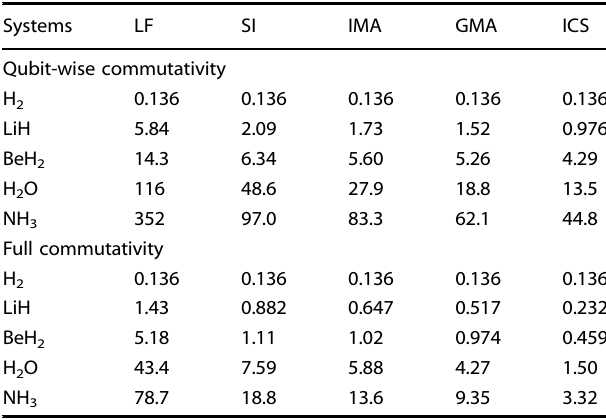
Table 1. Variances of the Hamiltonian estimators using exact